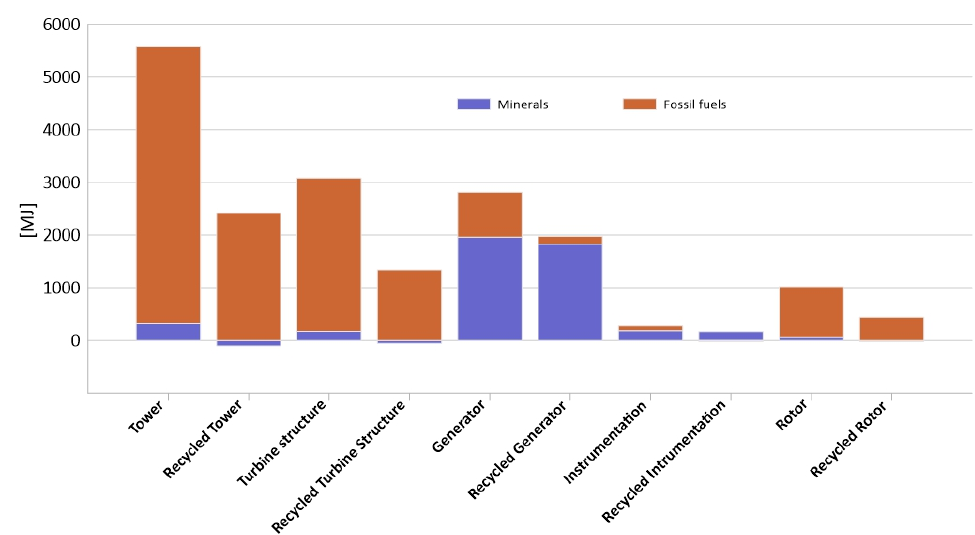
Figure 9. Results of characterization of environmental impacts occurring during the life cycle of elements of the construction of an innovative wind power plant comparison of results with and without recycling for the resources categories.